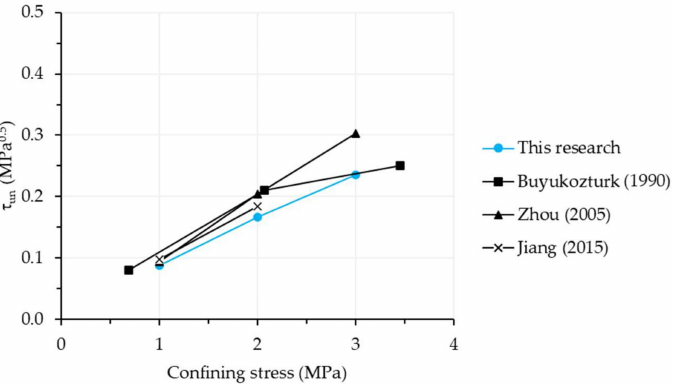
Figure 20. Maximum normalized shear stress in flat dry joints obtained for specimens from ordinary (black lines) [13,30,40] and RAC (blue line).